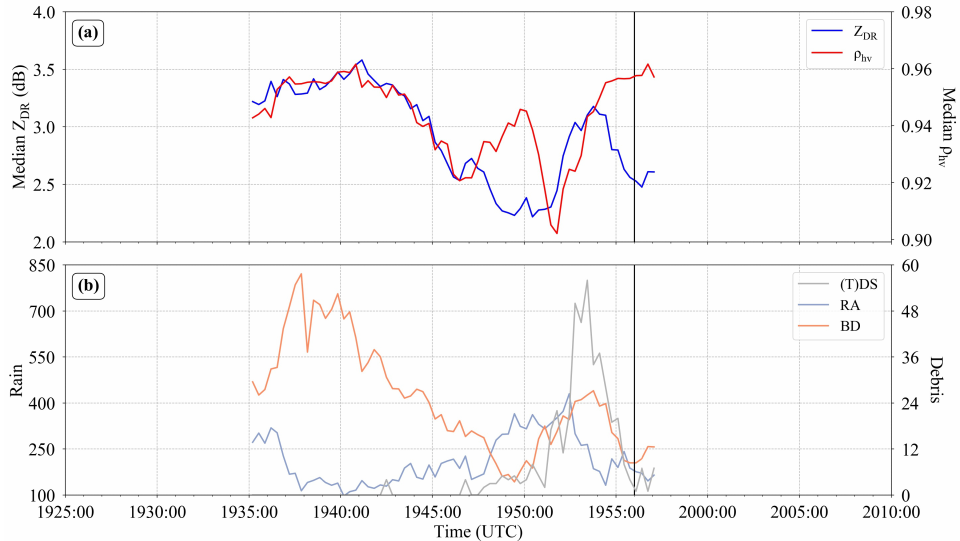
Figure 10. Using PX-1000: ( a ) Time series of the median Z DR and ρ hv within the hook echo from 1935 to 1957 UTC and ( b ) count of interpolated grid points where the HCA detects (T)DS (gray), RA (blue), and BD (orange). The solid black vertical line in both subfigures denotes the time of